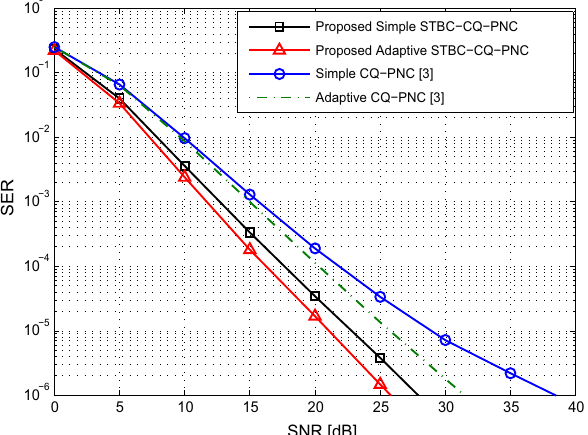
Fig. 5 SER performance of the adaptive STBC-CQ-PNC system with relay selection